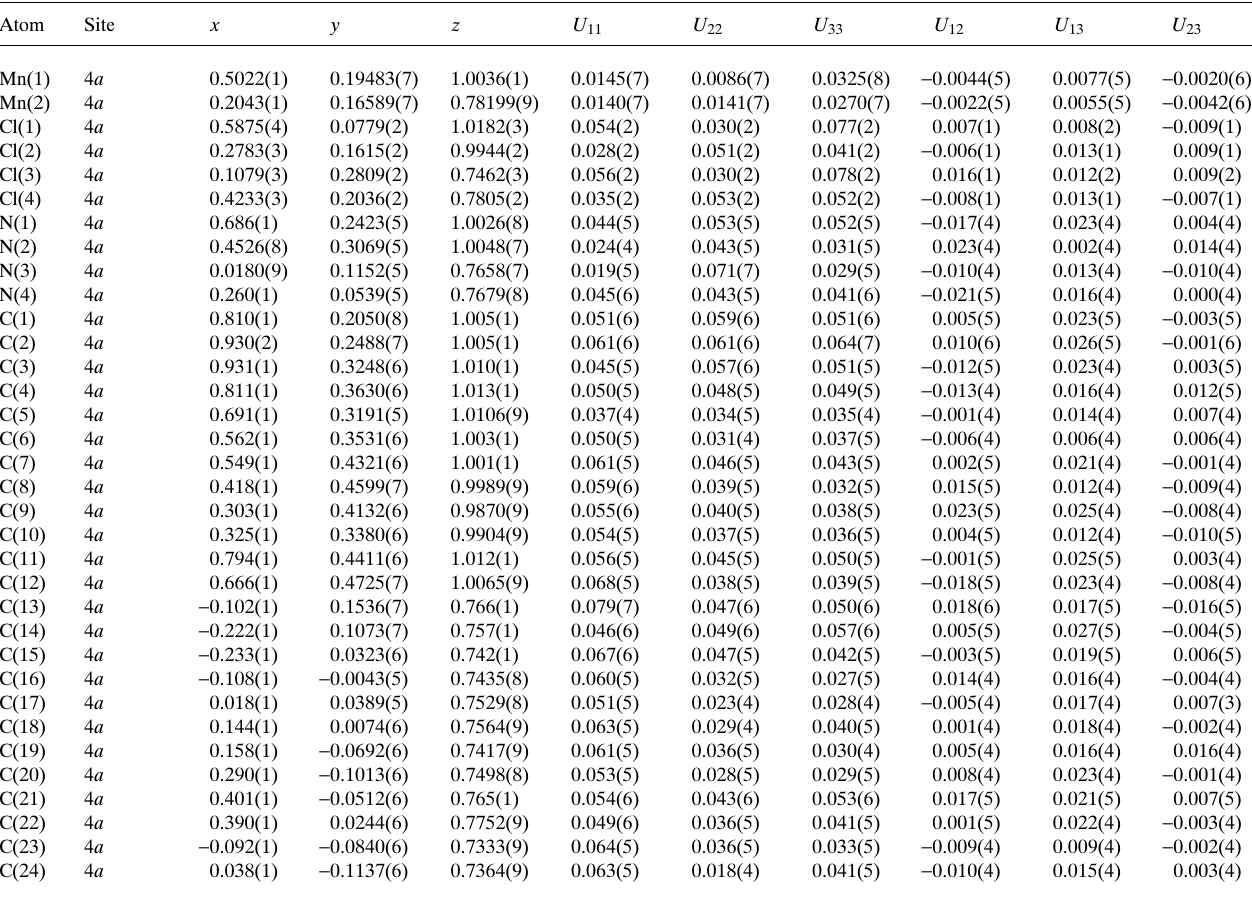
Table 3. Atomic coordinates and displacement parameters (in Å 2 )